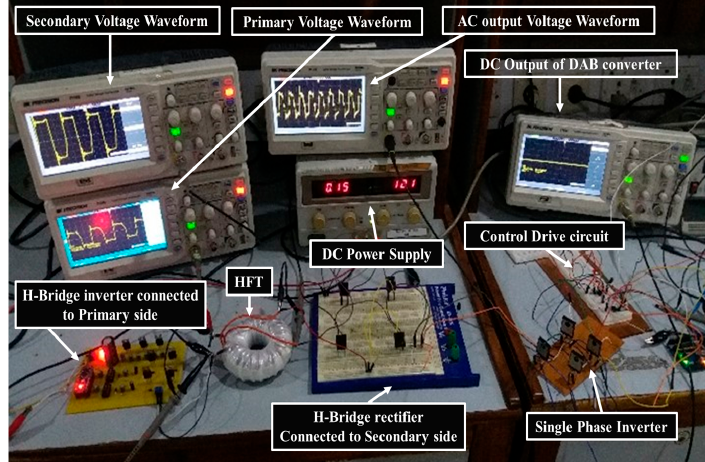
Figure 17. Prototype of dual active bridge-based boost inverter.